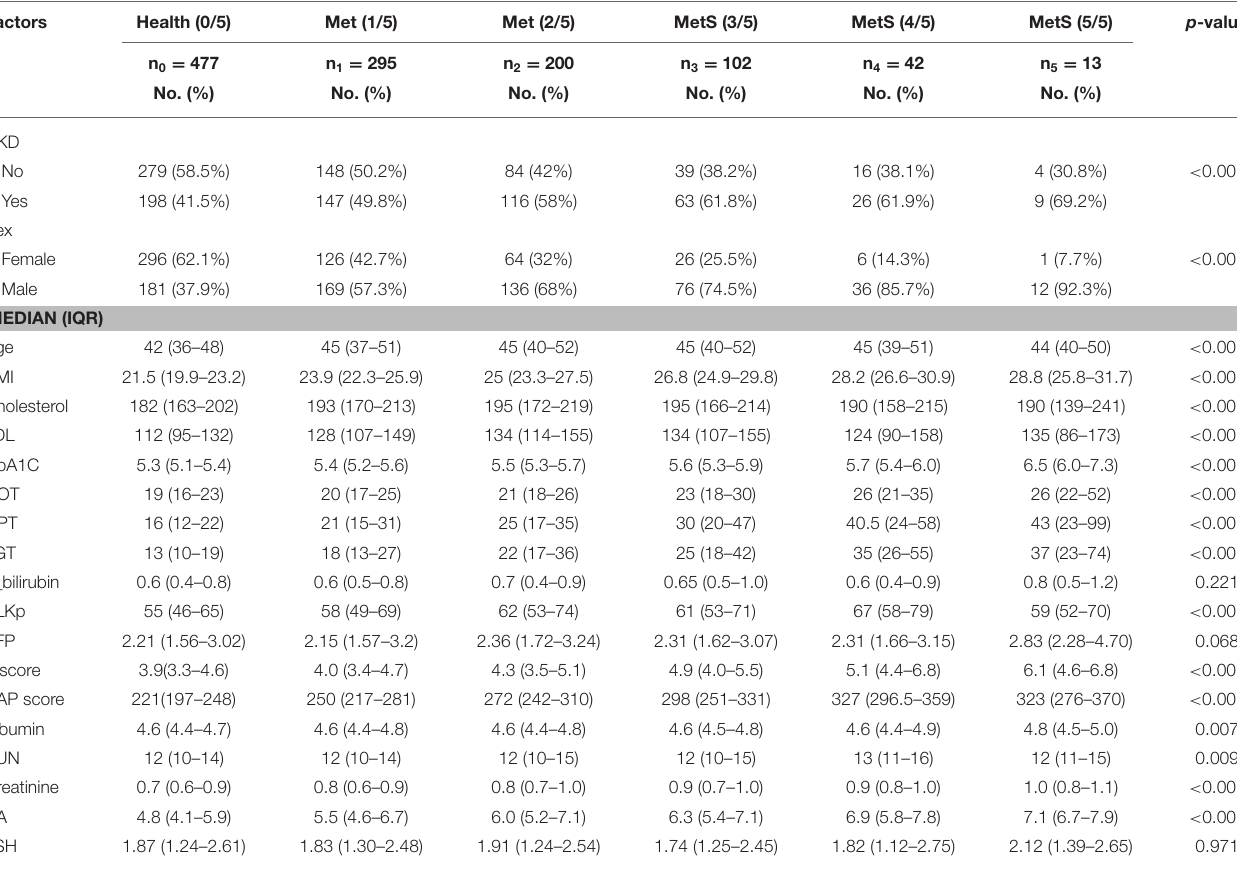
TABLE 1 | Descriptive statistics and non-parametric multinomial test for multiple levels of metabolic syndrome in health examination